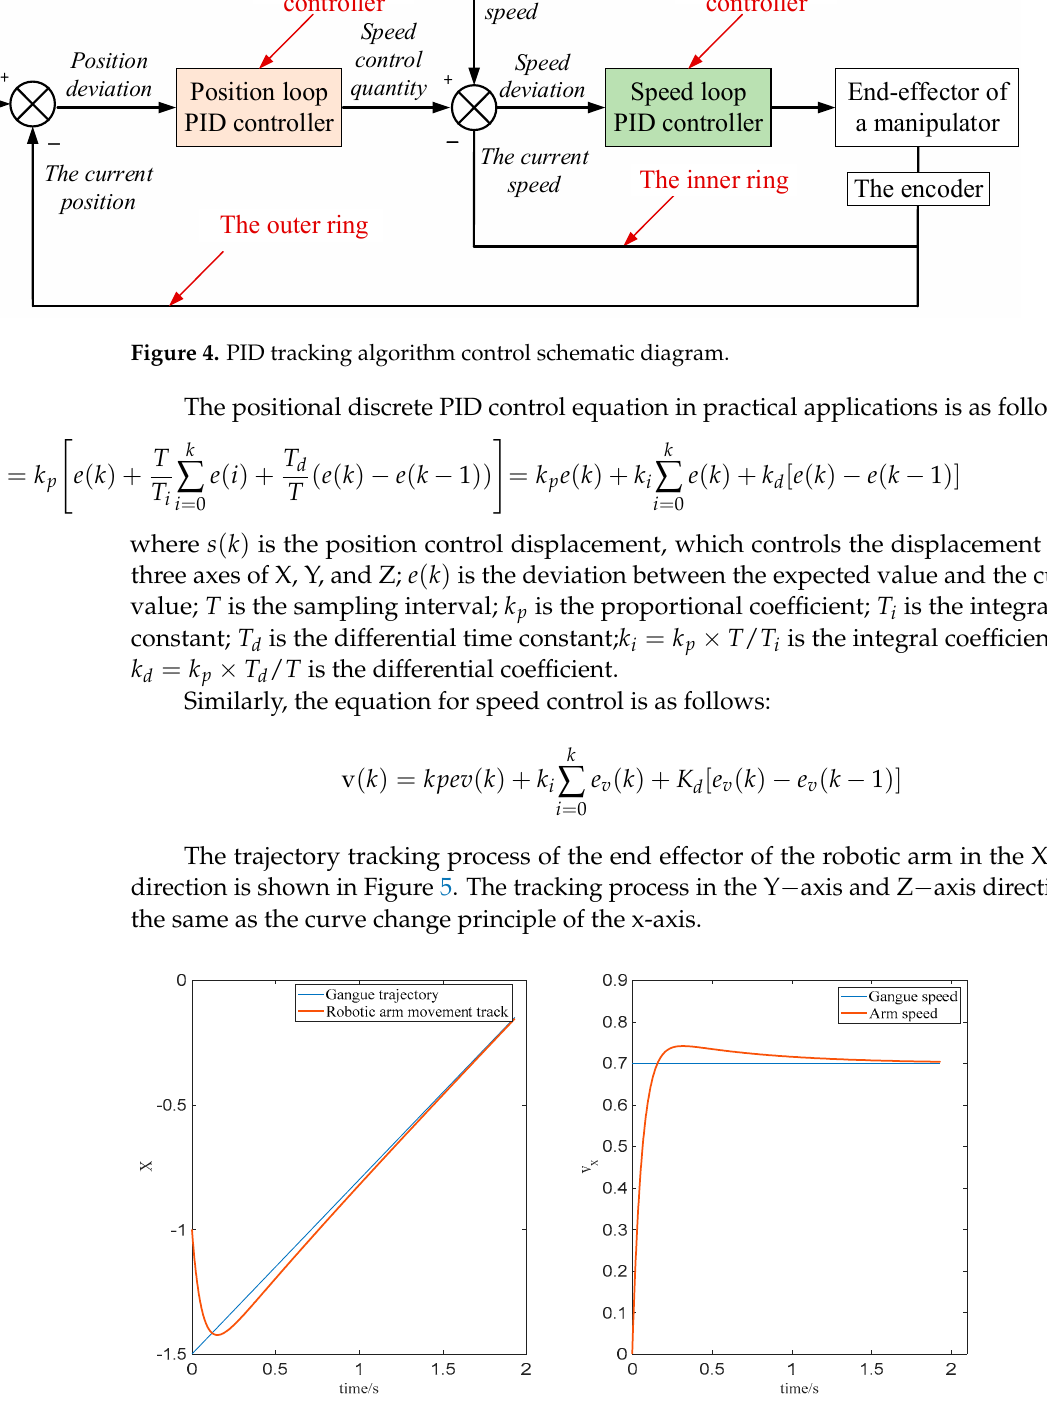
t of the robotic iz